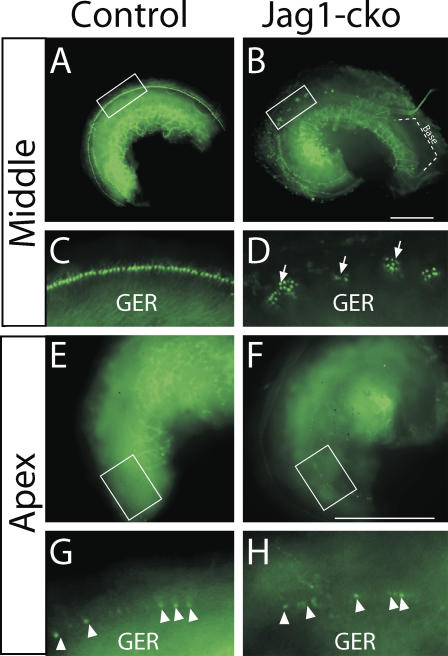
Early Analysis of the Patterns of Differentiation in the Jag1-cko Cochlea Indicates the Defects Are Caused by a Failure in the Formation of Sensory Cells and Not Subsequent DegenerationLectin staining of whole-mount cochlea at E16.5.(A) Normal patterning in wild-type control cochlea. GER, greater epithelial ridge.(B) Both the basal and middle portions of the cochlea are shown, although because it is much longer in the control (A), the very basal portion of the cochlea has been removed. Note the lack of hair cells in the basal portion of the Jag1-cko cochlea.(C–H) Boxed-in areas of (A) and (B) are shown at higher magnification in (C) and (D). Arrows in (D) indicate the abnormal patches of hair cells also observed at E18.5. Similarly, the boxed-in regions of (E) and (F) are shown at higher magnification in (G) and (H), demonstrating the few hair cells that are just beginning to differentiate in this region in both the control and the mutant (arrowheads). Scale bars = 500 μm for the corresponding panels.